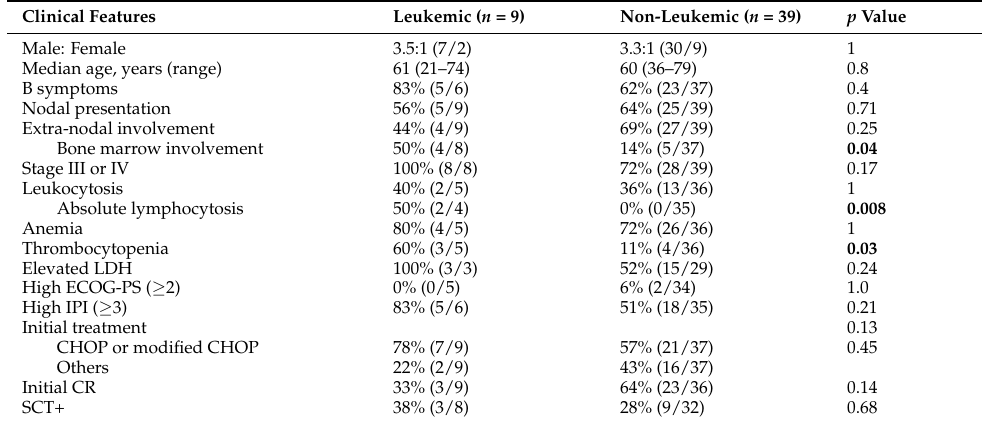
Table 2. Clinical Features of Patients with ALK-negative Anaplastic Large Cell Lymphoma (Leukemic vs. non-Leukemic